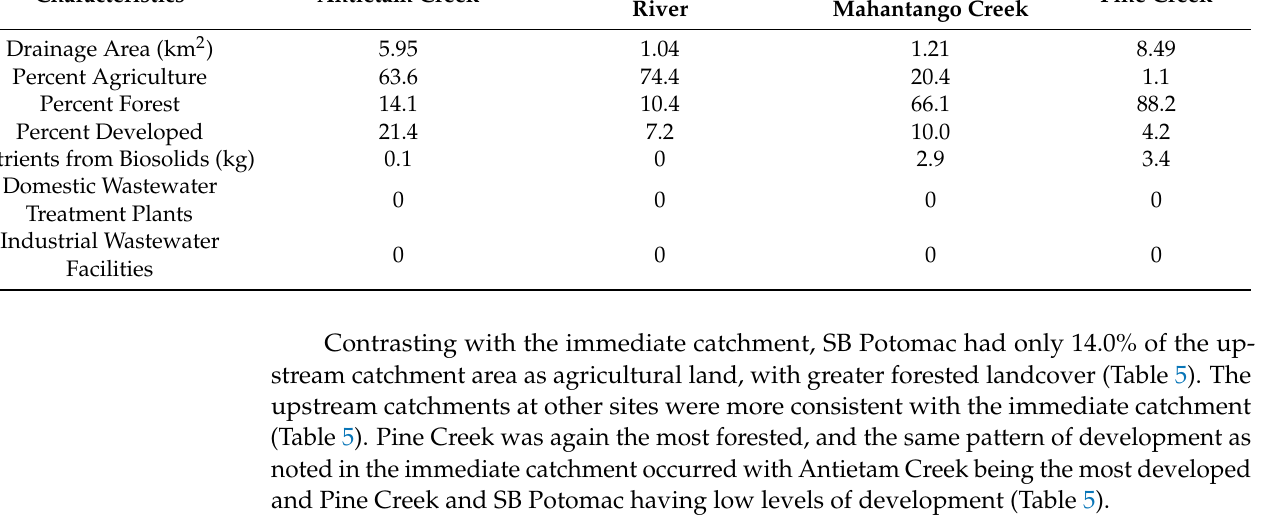
Table 5. Land-use characteristics of smallmouth bass sampling sites in the upstream cumulative catchment.